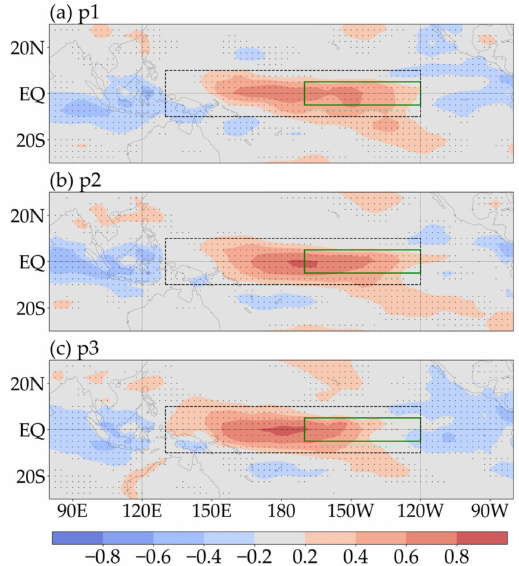
Figure 9. The correlation coefficients (blue-red scale) between the Niño-3.4 index series and zonal SSW anomaly field during the three periods ( a – c ). The p1, p2, and p3 are the same as in Figure 1. The green box is the Niño-3.4 region. The black dashed box is the main coupling region between the Niño-3.4 index and zonal SSW anomalies. Light black dots indicate that the results pass the Student t -test with a confidence level of 95%.